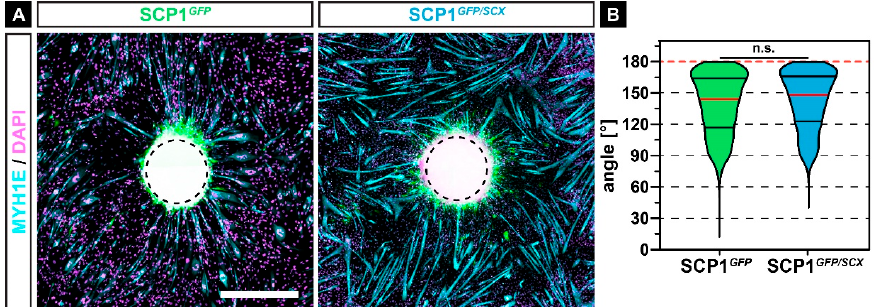
Figure 4. Immunohistochemistry against MYH1E (turquoise) after 7 days of myogenic differentiation in co-culture with SCP1 GFP or SCP1 GFP/SCX cell pellets revealed that most of the newly formed myofibers were orientated towards the middle of the cell pellets ( A ). However, the quantification of the orientation did not show any significant difference between both groups ( B ). Vertical lines in violin plots represent the median (red) and quartiles (black). Red dashed lines indicate a perfect orientation towards the center of the pellet. n.s.: not significant. Scale bar: 500 µm.